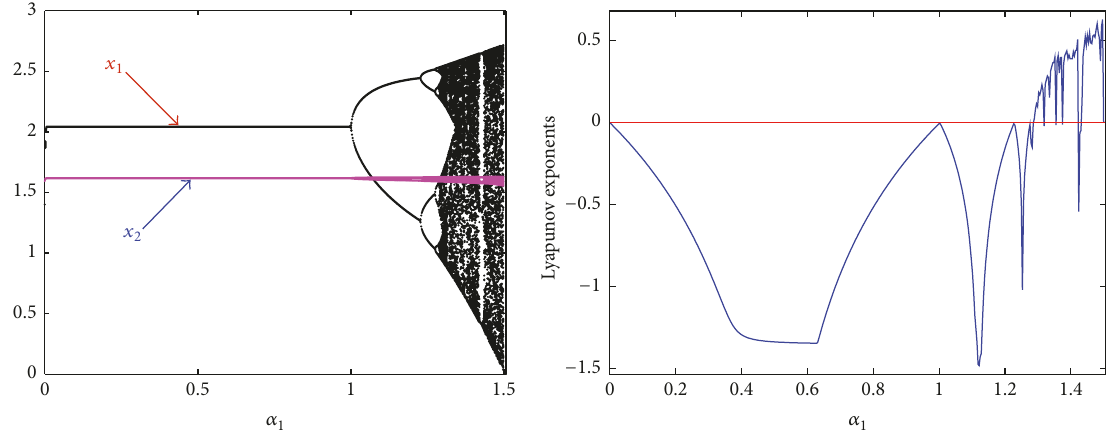
Figure 3: Bifurcation diagram and corresponding largest Lyapunov exponent with 𝛼 1 ∈ (0, 0.302] , for (𝛼 2 = 0.039, 𝛼 3 = 0.037)